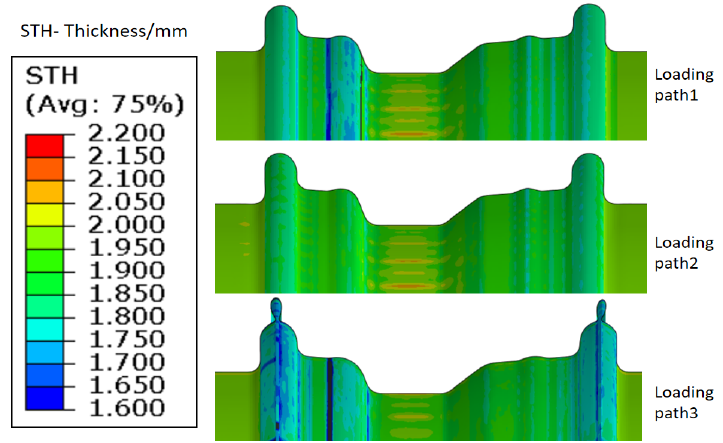
Figure 21. Thickness distribution of components under different loading paths.